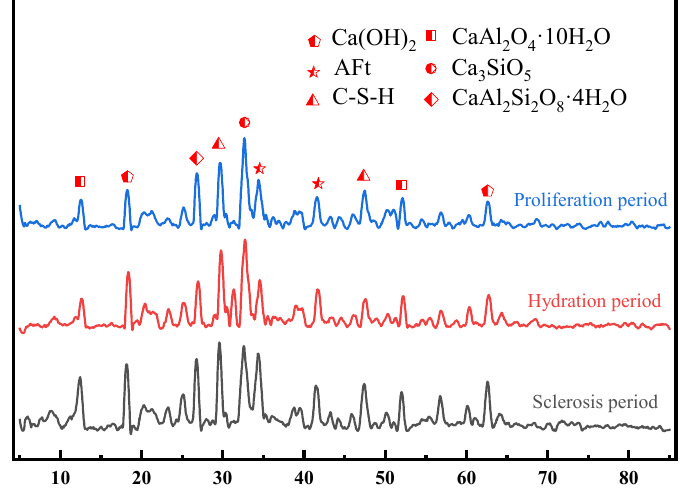
Figure 9. XRD pattern of hydration products.